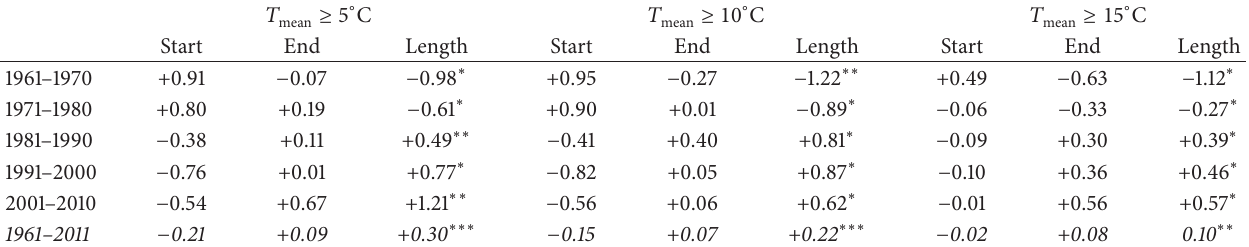
Table 3: Observed long-term changes (days per year) in growing season parameters over the Elbe River lowland. 𝑇 ≥ 5 ∘ C 𝑇 mean